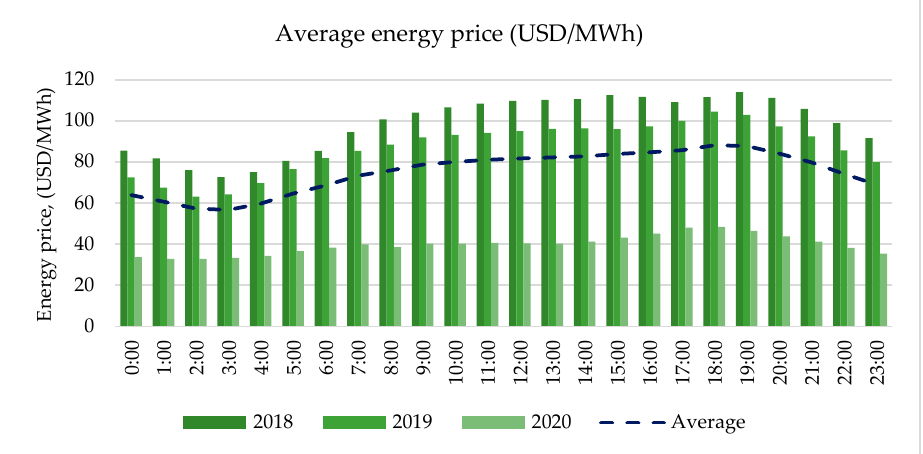
Figure 9. Hourly average of the PML per year. Own source with CENACE information, 2020.